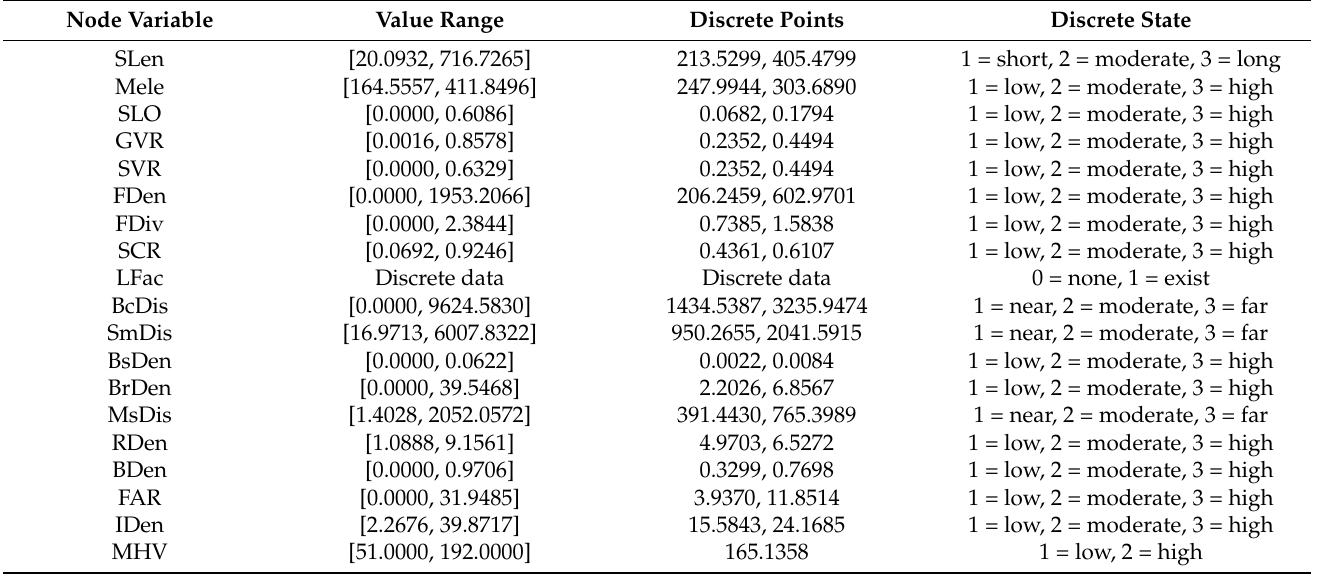
Table A1. Discretization methods of Bayesian network node